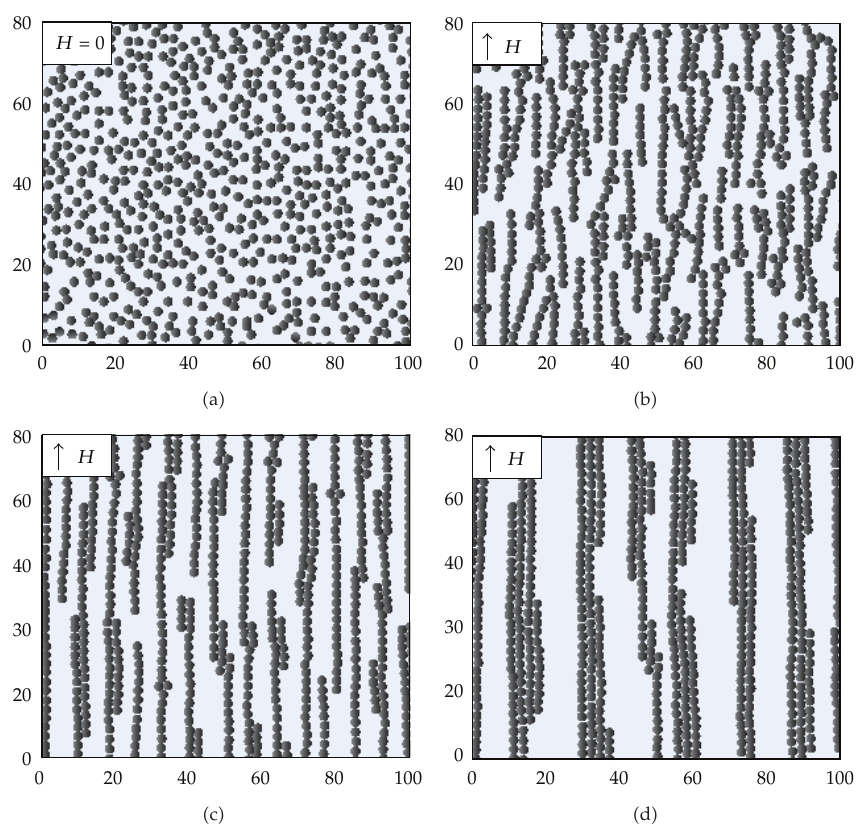
Figure 2: Influences of magnetic field strength on distributions of